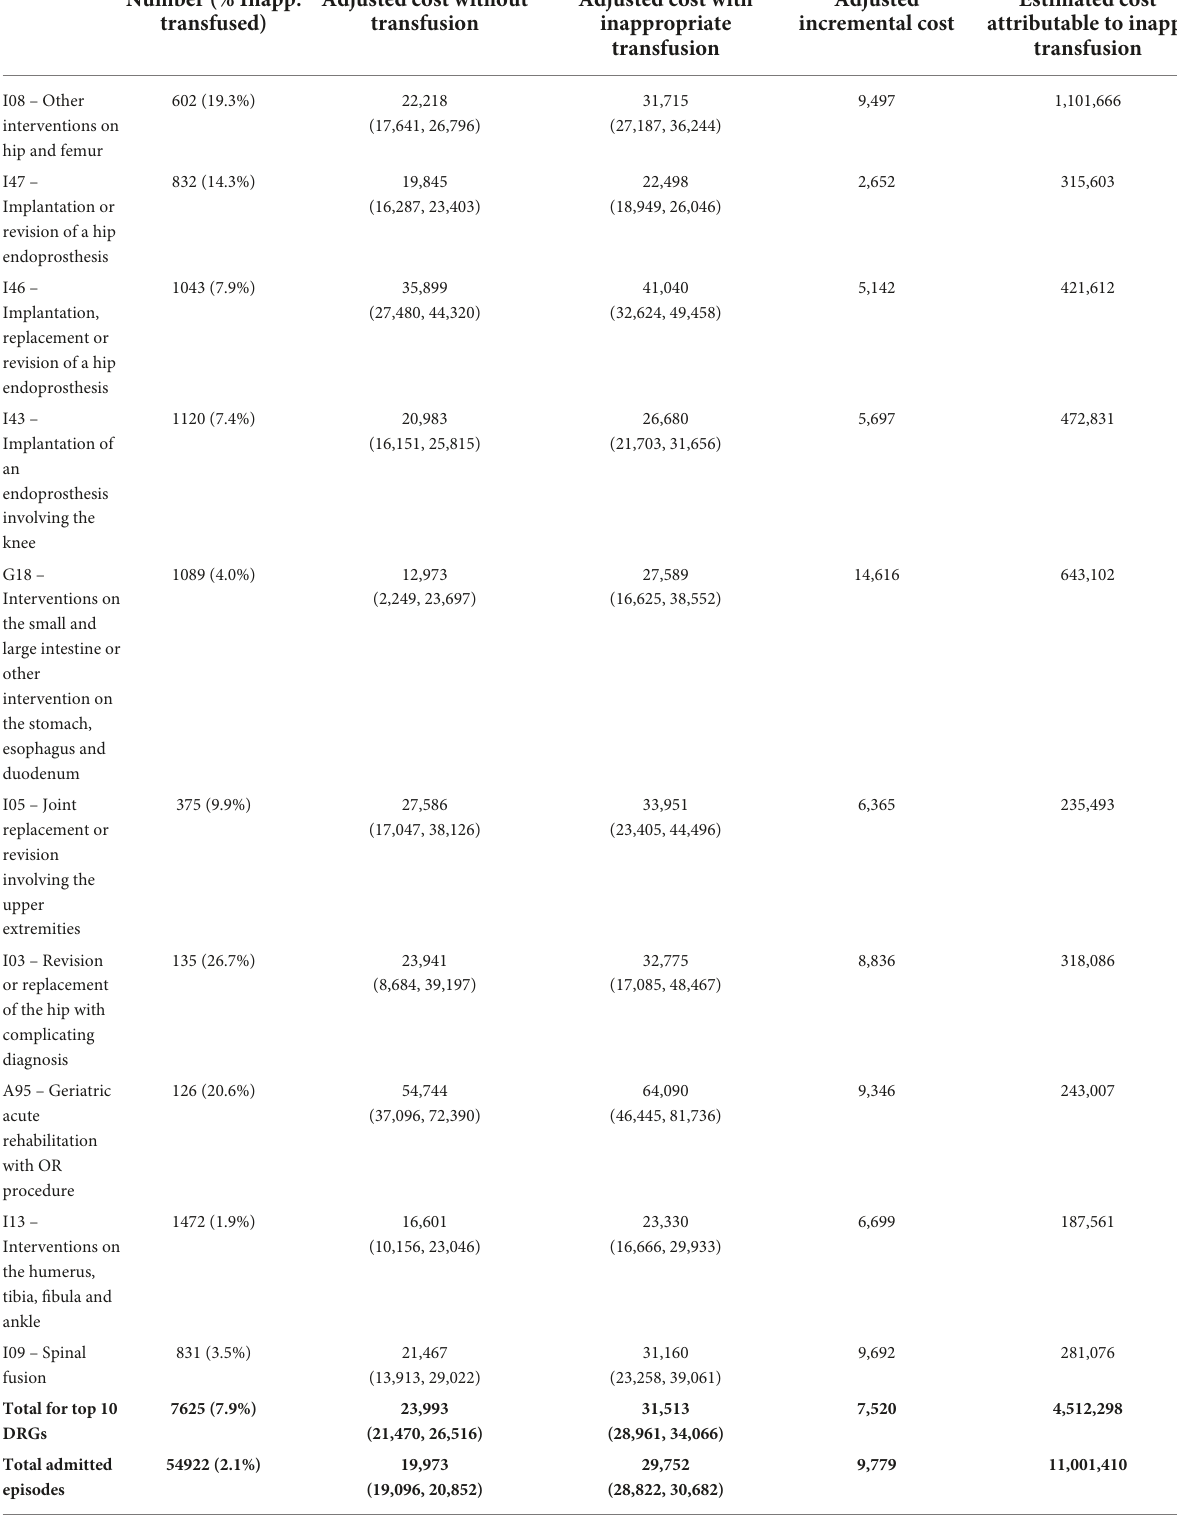
TABLE 3 Incremental costs (USD) of inappropriate red cell transfusion for top 10 transfused diagnosis-related groups (DRGs). Number (% Inapp. Adjusted cost without Adjusted cost with Adjusted Estimated cost transfused) transfusion inappropriate incremental cost attributable to transfusion